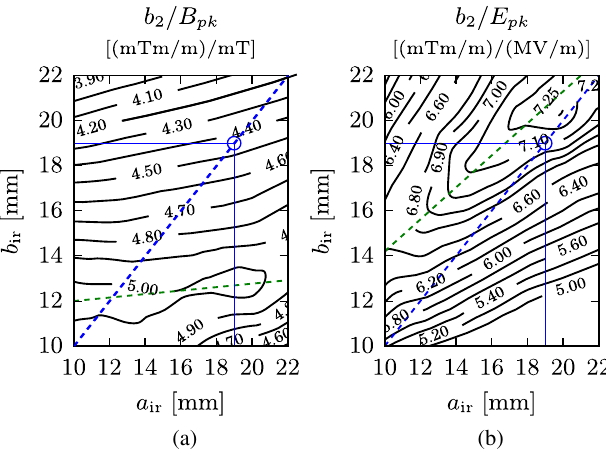
FIG. 13. Quadrupolar strength with respect to the magnetic (a) and electric (b) surface peak field as a function of the two half axes of the iris ellipse. In dashed blue, the reference line of a circular profile. In dashed green, regression line of the maximums in ( a , b ). The cavity length is optimized for each data set with ir ir ¼ 30 mm, a tapering angle α an iris radius r ir tangential angle α ¼ 1 deg. The circle emphasizes the optimized